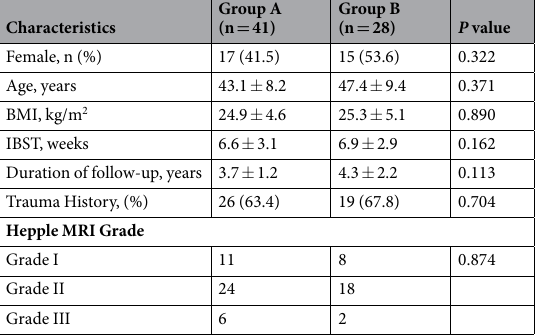
Table 1. Patients characteristics. Note: BMI:Body Mass Index; IBST: Interval between the onset of symptoms and the beginning of treatment.